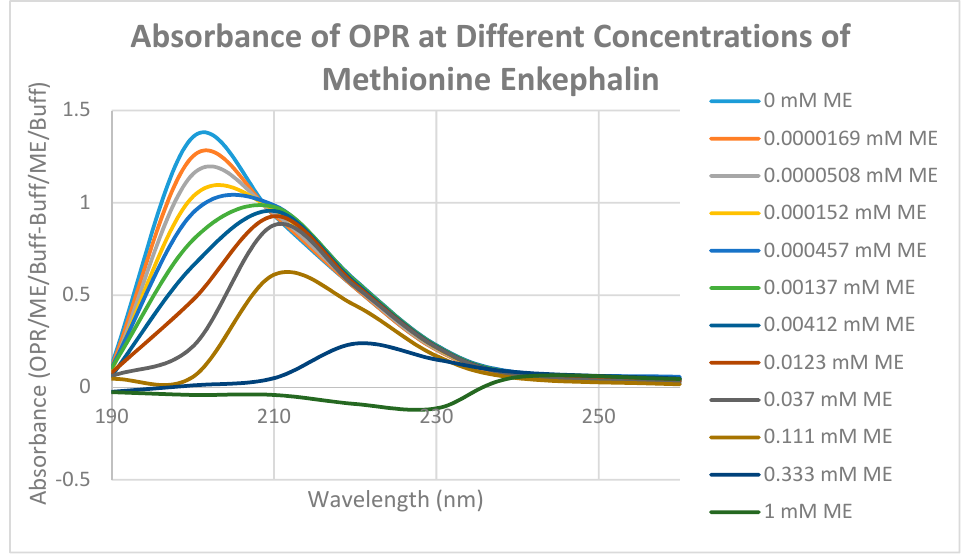
Figure 12. UV spectra of mu opioid receptor (OPR) with serial additions of methionine enkephalin (Met-Enk). Note the very significant differences between these spectra and those in Figures 10 and 11.